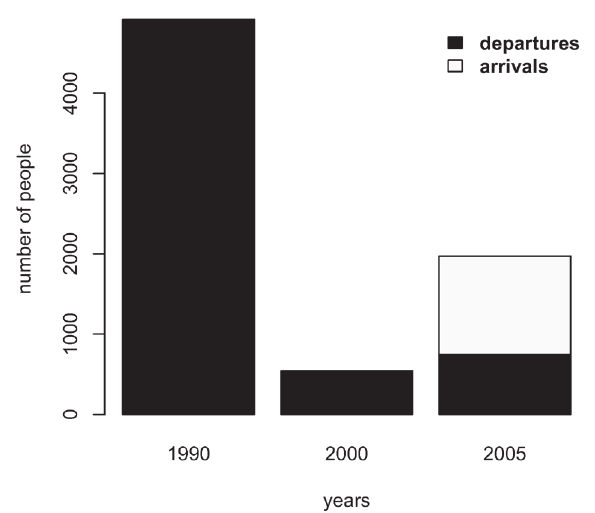
Figure 2. Population census data from 1990, 2000 and 2005 for a subsample of 22 communes across the study area. One commune typically includes four villages. In Romania the communist regime and its collapse in 1989 triggered mass emigration from these